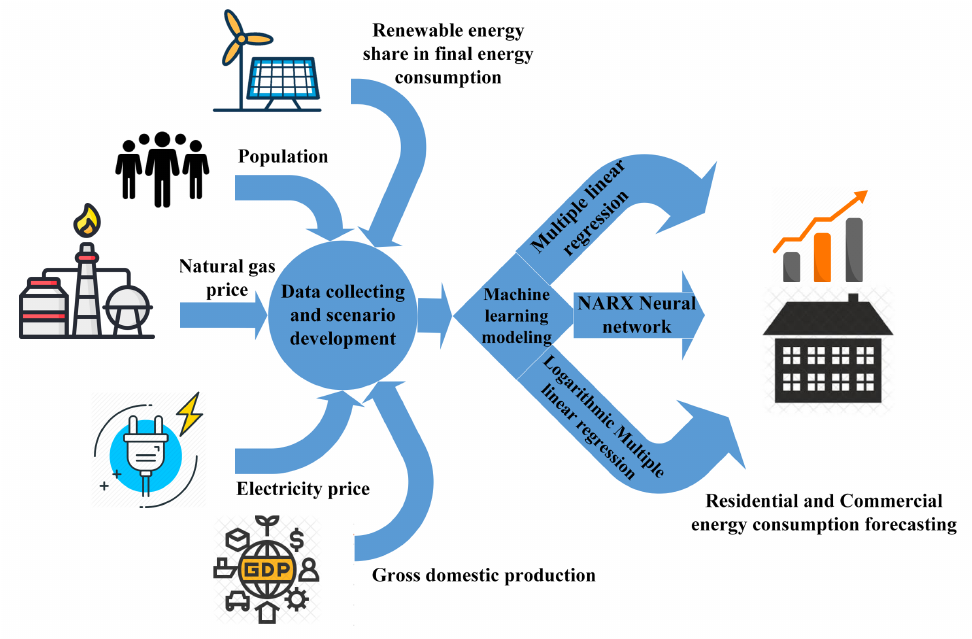
Figure 3. Our approach for forecasting residential and commercial energy